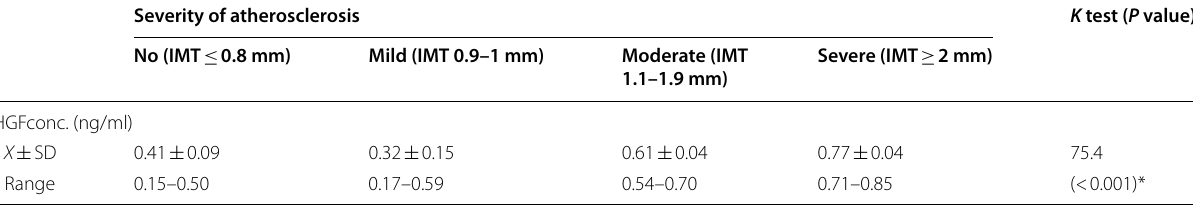
Table 11 The relation between HGF concentration and the degree of carotid atherosclerosis according to (IMT)